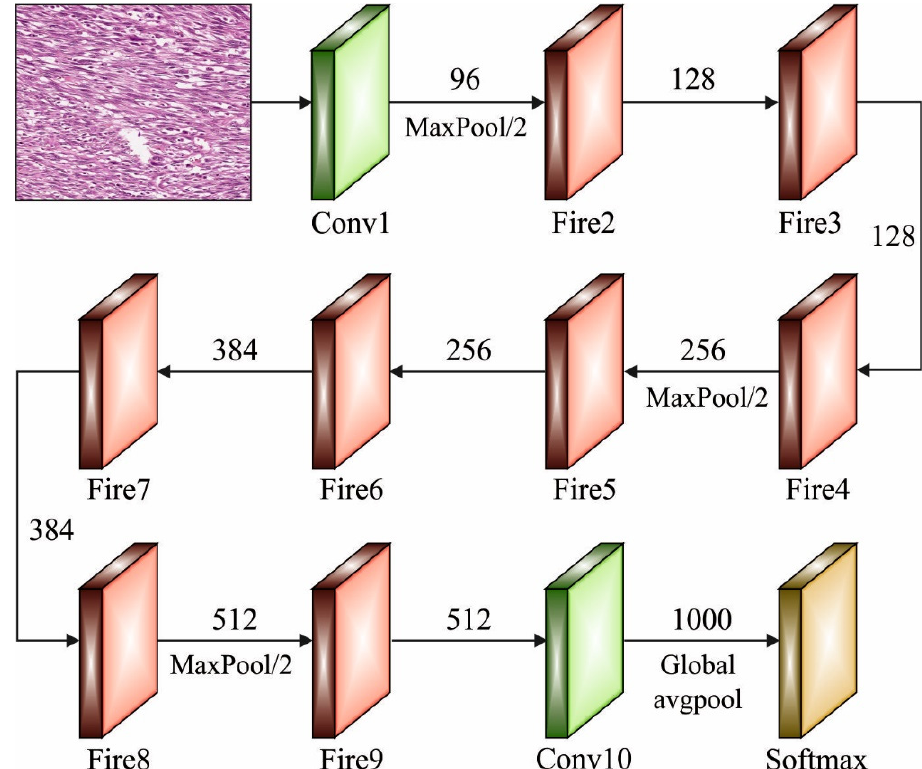
Figure 2. Structure of SqueezeNet Model.